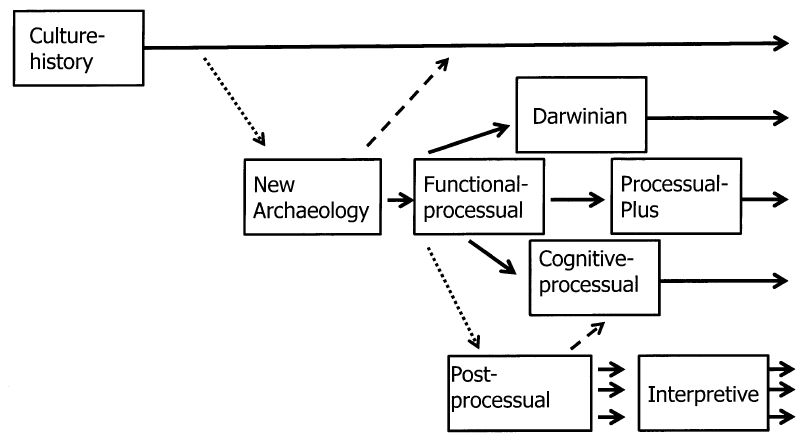
Figure 1: Schematic (and thus highly simpli fi ed) representation of the diversi fi cation of theoretical archaeology over time. Broken lines indicate more reactive or indirect relationships between schools of thought, the most antagonistic with dotted